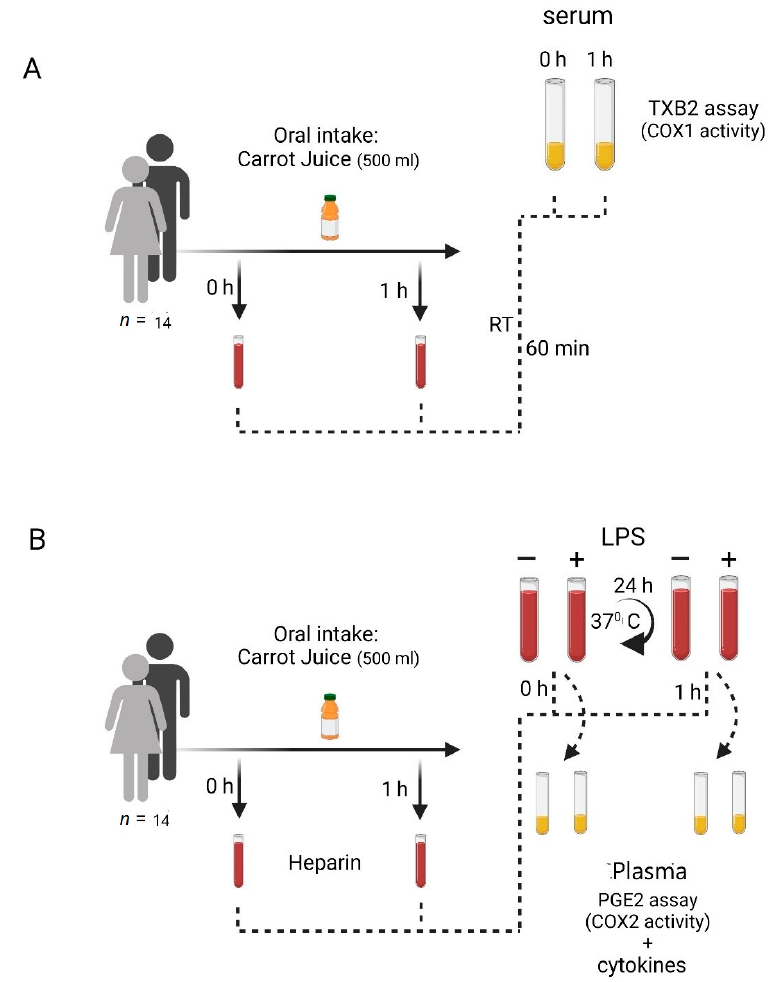
Figure 1. Study flow (A) Preparation of serum samples for analysis of thrombocyte COX-1 activity. (B) Preparation of plasma samples for analysis of inflammatory response (PGE2, IL-1 α , IL-1 β , IL-6, IL-16 and TNF α ) to LPS. Cyclooxygenase (COX), Tromboxane (TX), Prostaglandin (PL), Interleukin (IL), Tumor Necrosis Factor (TNF).